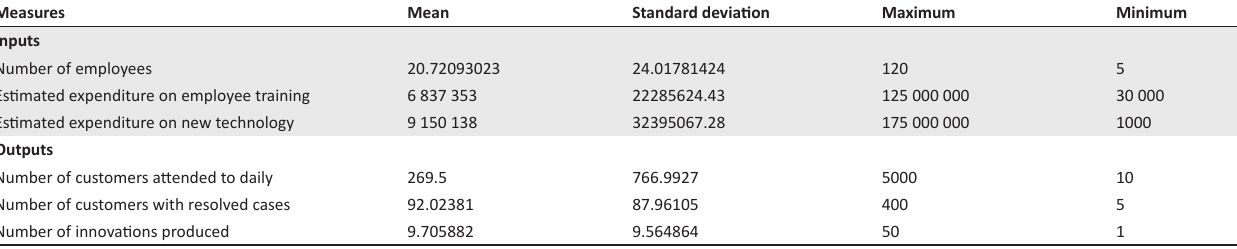
TABLE 1: Input and output measures for productivity of telecommunication firms. Measures Mean Standard deviation Maximum Inputs Number of